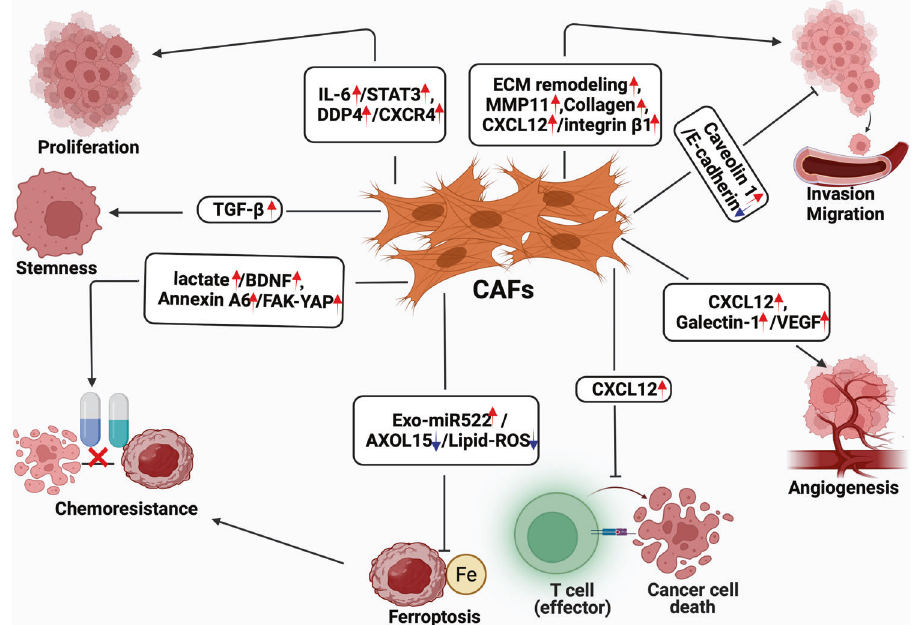
Fig. 2 Functional heterogeneity of GC CAFs. CAFs play an essential role in the process of tumorigenesis and cancer progression such as GC cell proliferation, stemness, metabolic changes, and chemoresistance, as well as invasion, migration, EMT, angiogenesis, and immunosuppression in GC by releasing multiple ECM proteins and regulatory